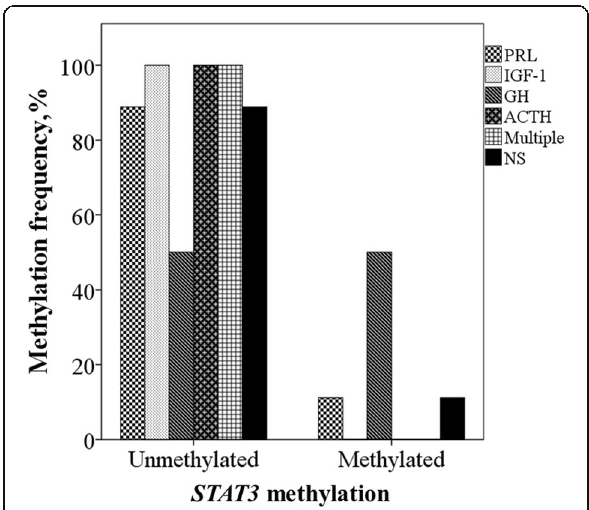
Fig. 2 PA hormone distribution in methylated and non-methylated STAT3 gene groups. PRL – prolactin, IGF-1 – insulin-like grow factor 1, GH – growth hormone, ACTH – adrenocorticotropic hormone, multiple – PAs secreting more than one hormone, NS – non-secreting